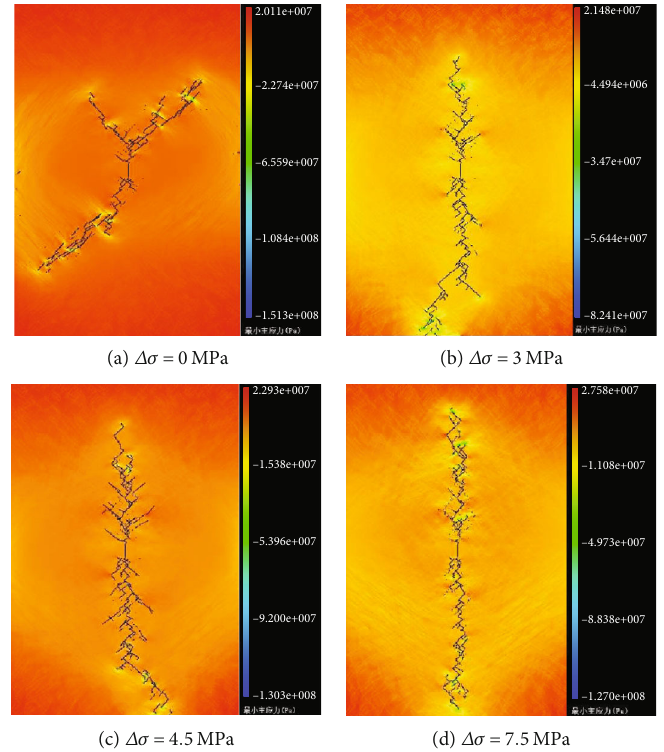
Figure 15: Hydraulic fracture propagation patterns under di ff erent in-situ stress anisotropy.